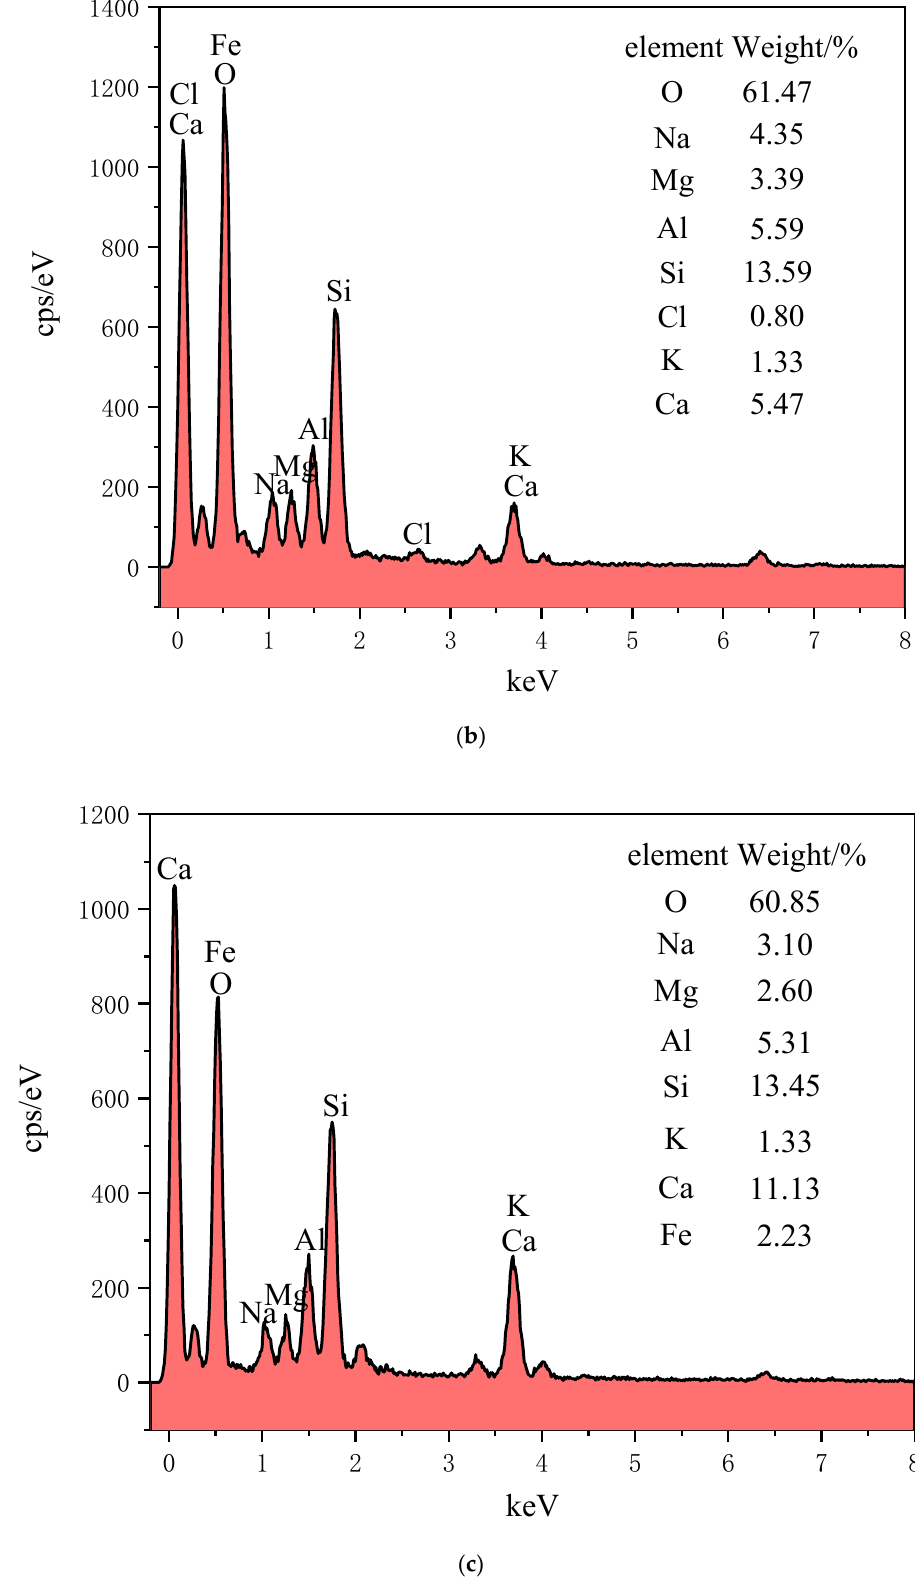
Figure 9. EDS point sweep. ( a ) Upper left corner substance in Figure 8a, ( b ) Lower left corner substance in Figure 8a and ( c ) Upper left corner substance in Figure 8a.